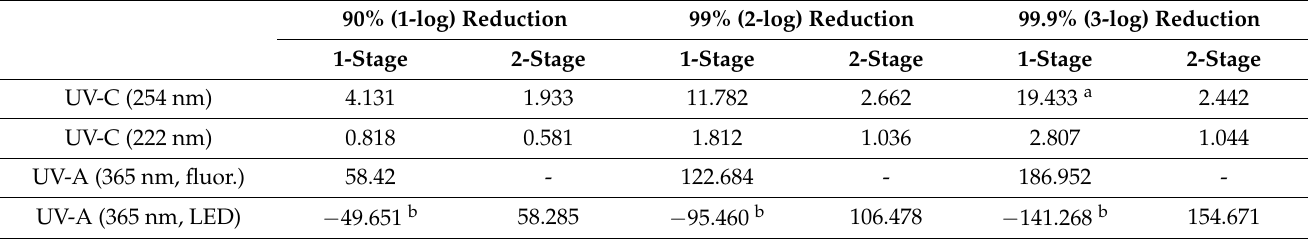
Table 3. Estimated the UV dose (mJ/cm 2 ) needed for target % aerosolized PRRSV reduction in fast-moving air, using both one-stage and two-stage inactivation